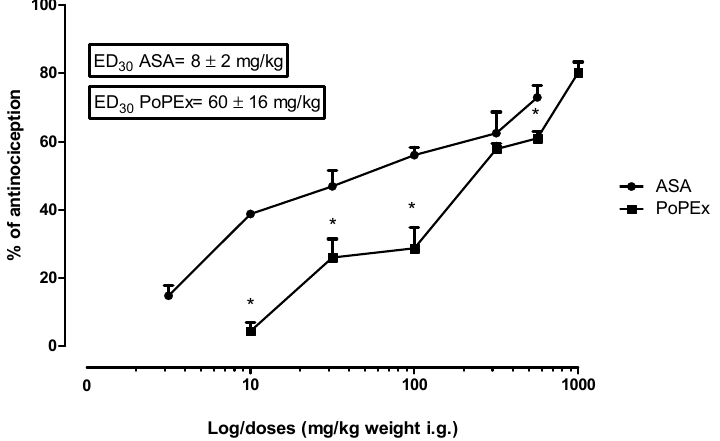
The antinociceptive effect, expressed in percentage, was obtained from the mean of the AUC of the number of paw flinches of each group of animals ( n = 6) in the 2% formalin test. Drugs were administered intragastrically. * = statistically significant difference ( p < 0.05) versus the vehicle group.